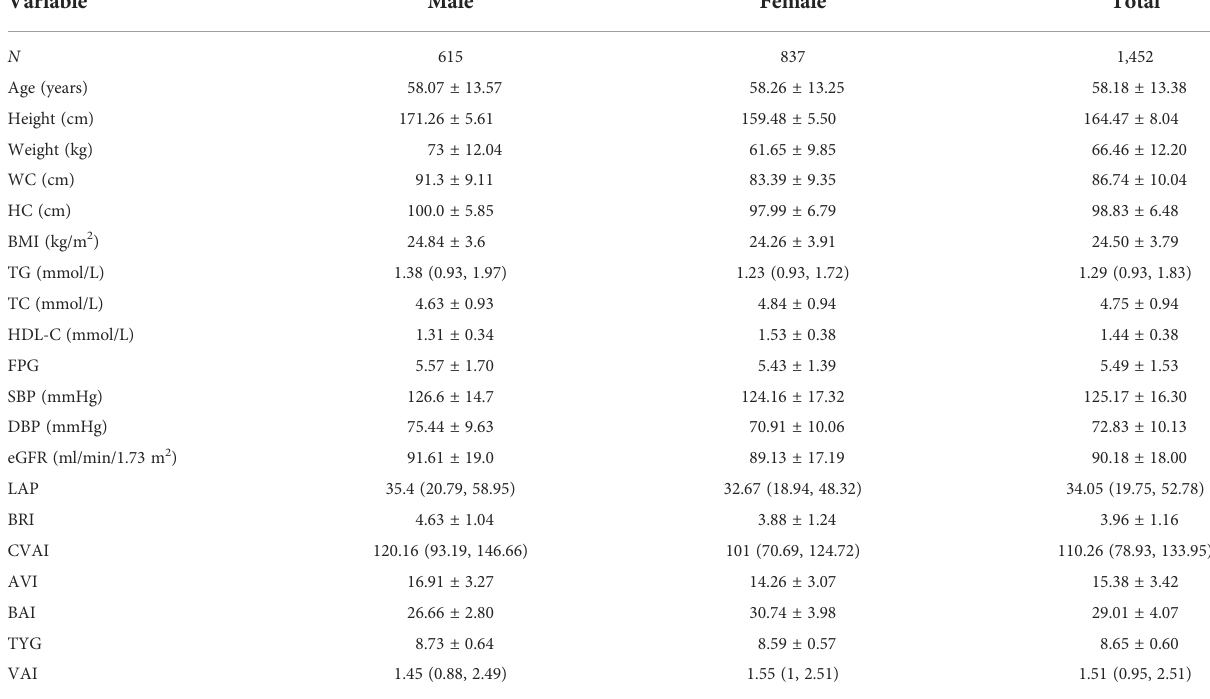
TABLE 1 Basic characteristics of the